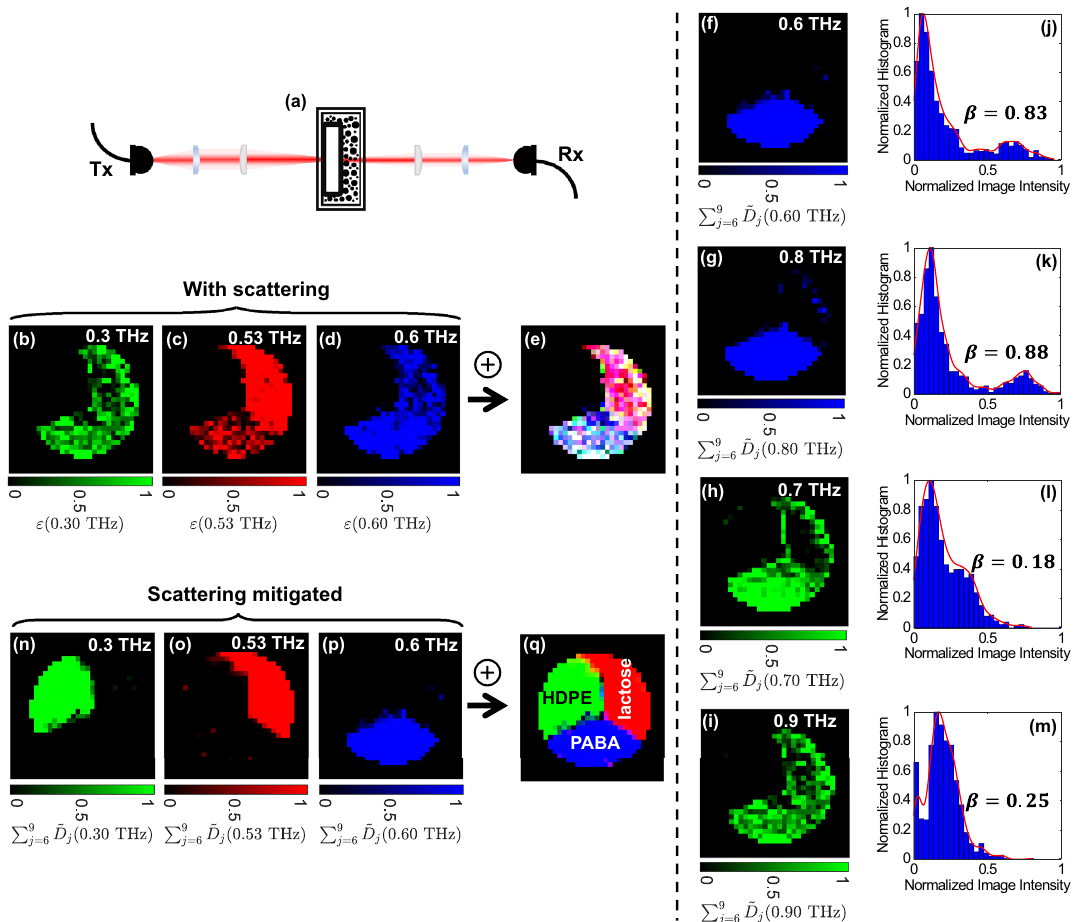
Figure 2. Terahertz chemical mapping through turbid media, ( a ) the imaging apparatus at the detection angle θ = 0 ◦ , ( b ) the normalized extinction coefficient at 0.3 THz (green color map), ( c ) 0.53 THz (red color map), ( d ) 0.6 THz (blue color map), ( e ) the superposition of the images in ( b - d ), ( f ) image formed using the normalized 9 9 ˜ D ˜ D summation of the sixth to ninth-level wavelet details vectors at 0.6 THz (i.e., (cid:31) j (0.6 THz)), ( g ) (cid:31) j j = 6 j = 6 9 9 ˜ D ˜ D (0.8 THz), ( h ) (cid:31) j (0.7 THz), ( i ) (cid:31) j (0.9 THz), ( j - m ) the normalized histograms of the images shown j = 6 j = 6 in ( f - i ), respectively, the bimodality coefficient value is given for each histogram, ( n ) the normalized summation of the sixth to ninth-level wavelet details vectors at 0.3 THz (green color map), ( o ) 0.53 THz (red color map), (p) 0.6 THz (blue color map), and ( q ) the superposition of the images in ( n - p ). The color maps are generated using MATLAB R2020b, https:// www. mathw orks. com/ produ cts/